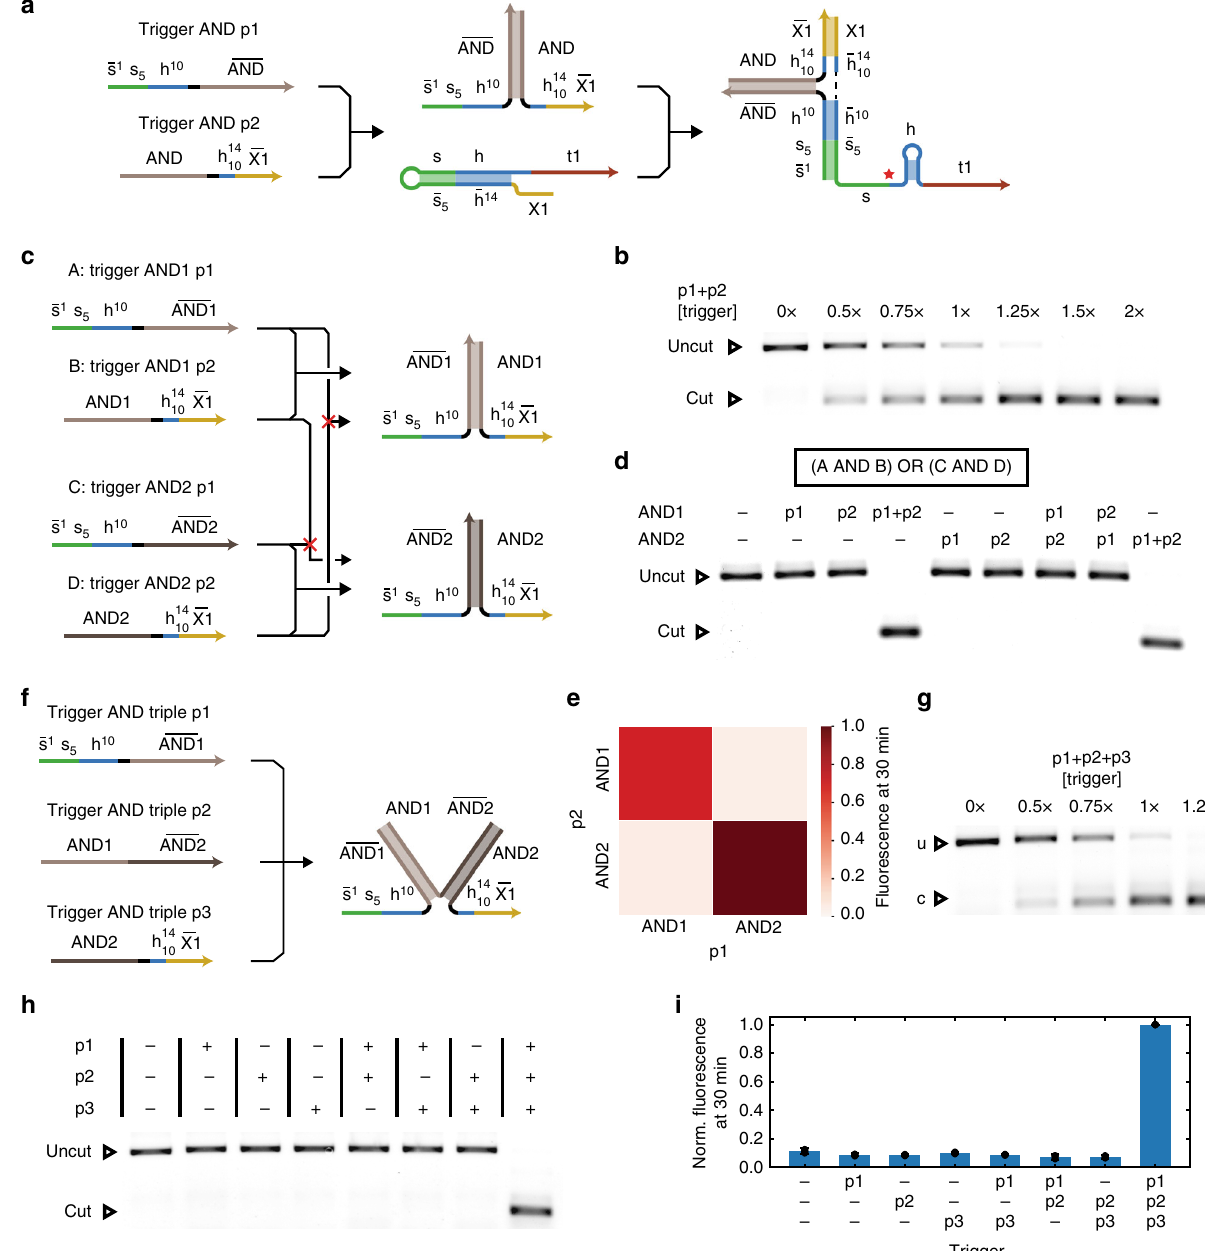
Fig. 4 Trigger AND gates for SD gRNA activation. a Principle of AND gates for SD gRNAs. The trigger is split in two and can reassemble based on a hybridization domain. The reassembled trigger activates the SD gRNA. b Agarose gel assaying target cutting for different amounts of the two assembled trigger parts (uncut: 1190 bp, cut: 357 bp). c Orthogonal hybridization domains lead to orthogonal AND gates. d Agarose gel assaying target cutting for different combinations of trigger RNAs. Only two cognate trigger parts lead to signi fi cant cutting activity (uncut: 1190 bp, cut: 357 bp). e ssDNase assay for orthogonal AND triggers ( N = 3). f The principle of the two-input AND gate can be extended to a three-input AND gate by distributing the hybridization domains. g Agarose gel assaying target cutting for different amounts of the three assembled trigger parts (uncut: 1190 bp, cut: 357 bp). h Agarose gel demonstrating functionality of the three-input AND gate (u, uncut: 1190 bp, c, cut: 357 bp). i ssDNase assay of gRNA activation by different combinations of triple AND triggers. Only all three triggers together lead to an activation signi fi cantly above the background level ( N = 3, t -distribution two-sided 90% con fi dence interval). Source data are provided as a Source Data fi